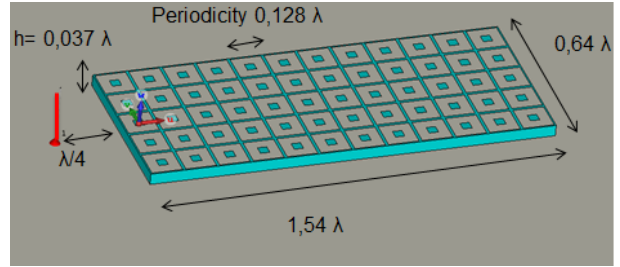
FIGURE 2. Dimensions of the L-band SIS mockup